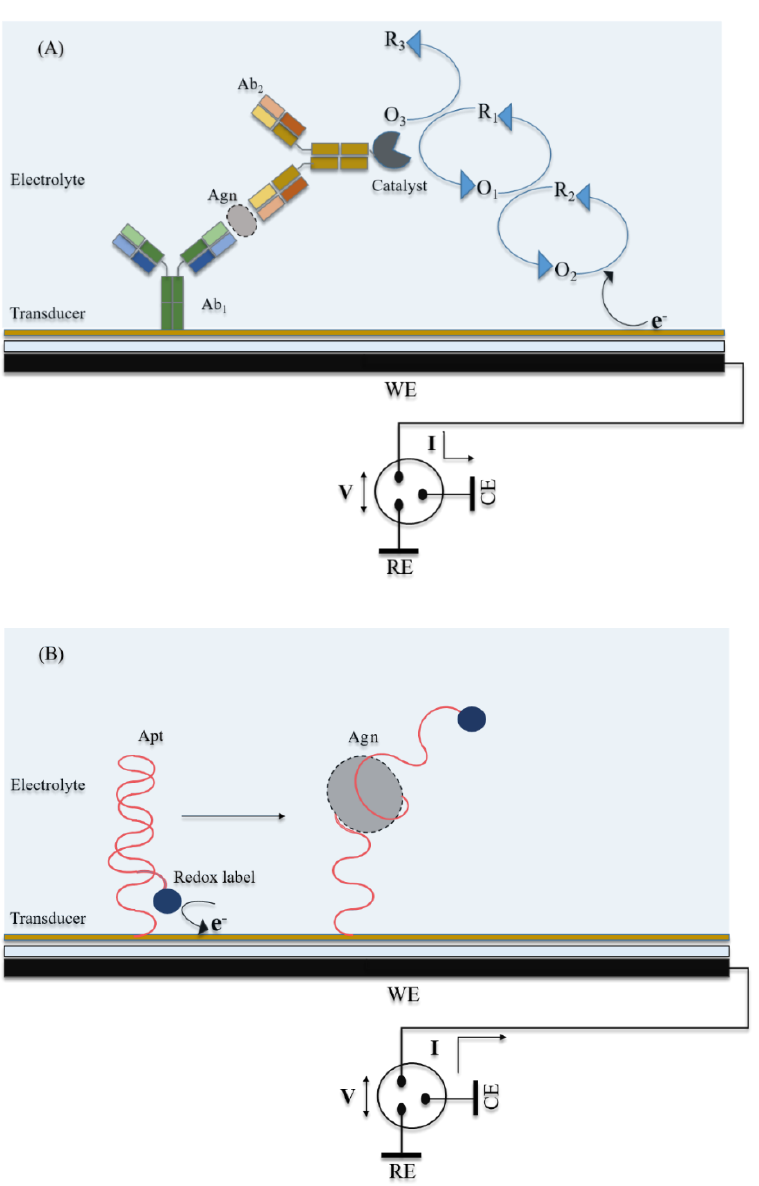
Figure 2. Schematic illustrations of ( A ) electrochemical immunosensor and ( B ) electrochemical aptasensor. (Agn = Antigen, Ab 1 = Primary antibody, Ab 2 = Secondary antibody, Apt = Aptamer, R = Reduced species, O = Oxidized species, V = Applied voltage, I = Current signal).